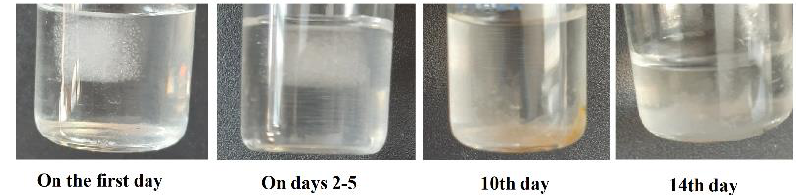
Figure 6. The degradation process of the produced sponge for 2 weeks.